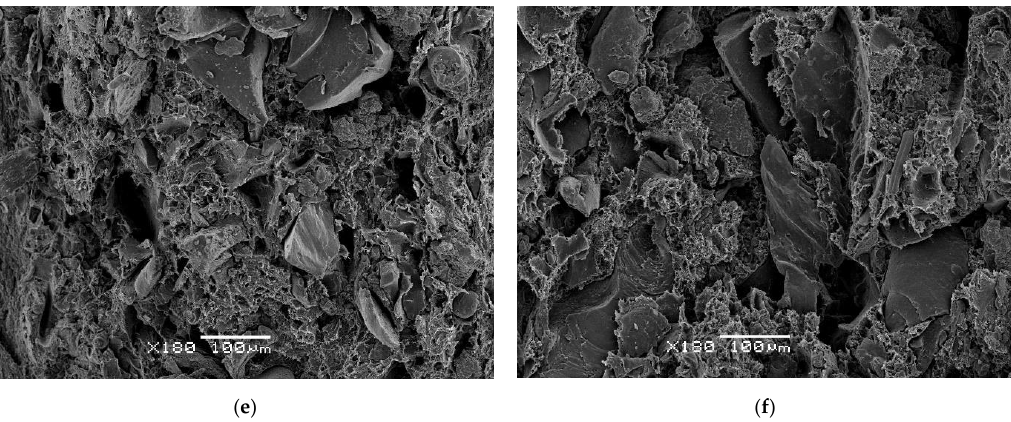
Figure 10. Scanning electron microscopy images, at 180 magnification, of several polymeric composites and different GTR amounts: ( a ) 80% PVC + 20% GTR. ( b ) 50% polypropylene + 50% GTR. ( c ) 30% HDPE + 70% GTR. ( d ) 80% EVA + 20% GTR. ( e ) 60% PS + 40% GTR. ( f ) 50% ABS + 50% GTR.